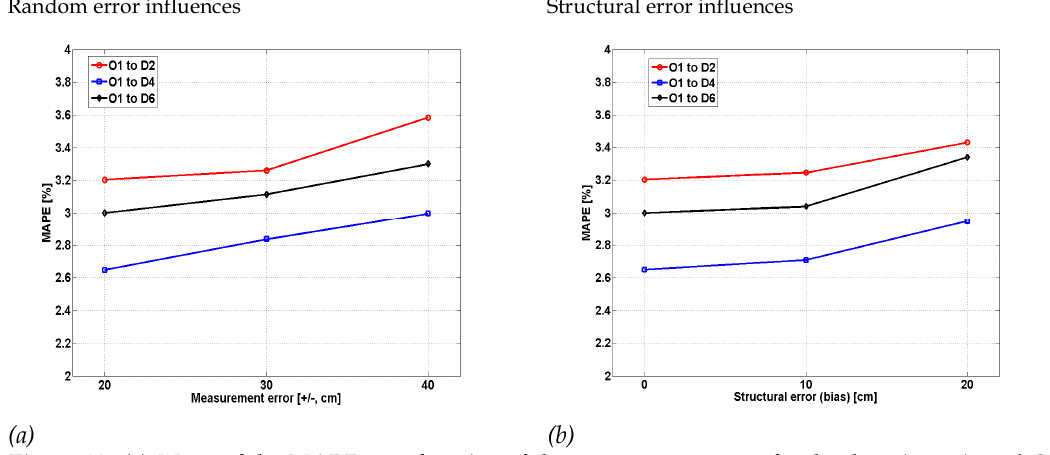
Figure 10. (a) Mean of the MAPE as a function of the measurement error for the three investigated OD- combinations, (b) Mean of the MAPE as a function of the structural error for the three investigated OD- combinations.